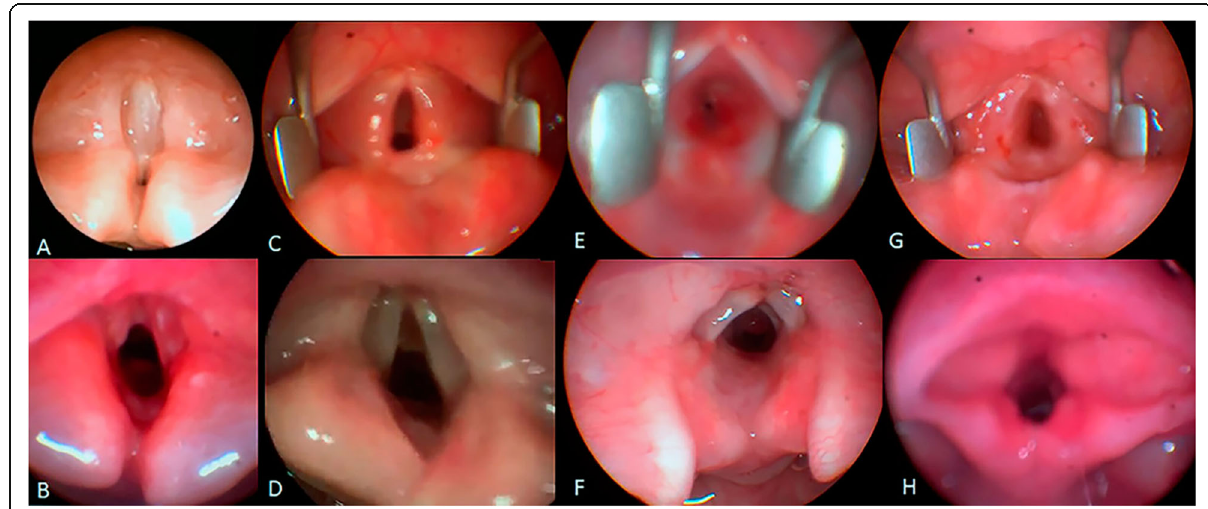
Fig. 1 Laryngotracheal stenosis before and after procedures. a , b (Patient 1) Laryngeal web type III; after procedure, absence of residual stenosis. c , d (Patient 11) Subglottic stenosis MC III + glottic posterior (transglottic); after procedure, absence of residual stenosis. e , f (Patient 13) Subglottic stenosis MC III + glottic posterior (transglottic); after procedure, absence of residual stenosis. g , h (Patient 16) Subglottic stenosis MC IV + glottic posterior (transglottic); after procedure, absence of residual